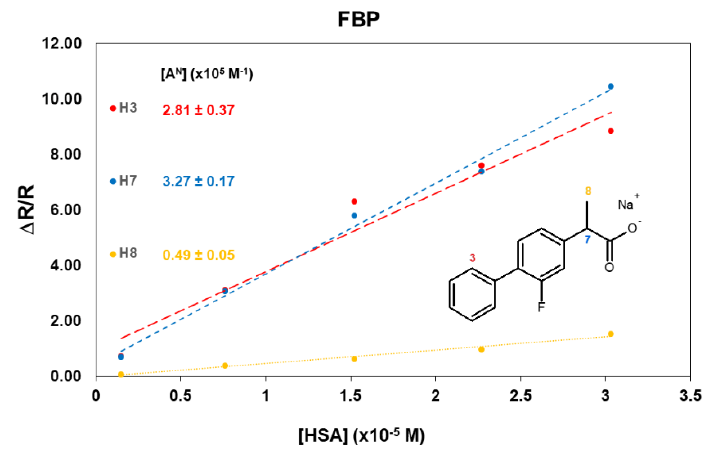
Figure 3. Normalized mono-selective relaxation rates plotted vs. HSA concentration, and calculated affinity indexes for FBP protons.